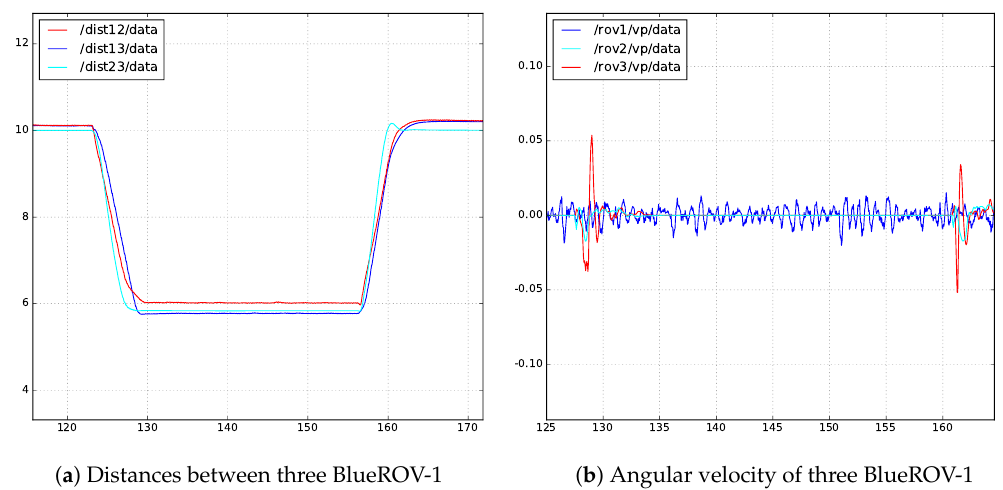
Figure A2. Velocities and distances of three BlueROV-1 while crossing a narrow area.